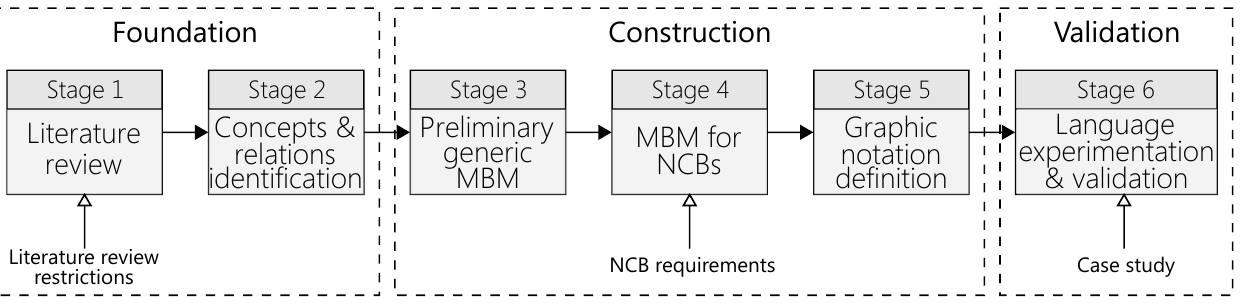
Figure 1. Meta-business model (MBM) construction